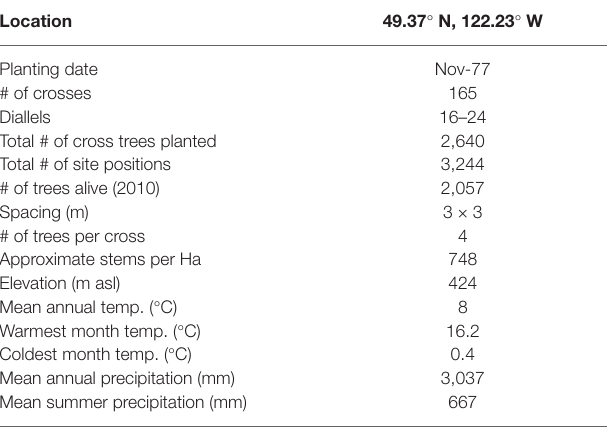
TABLE 1 | Progeny trial summary for the Lost Creek Douglas-fir progeny tests in British Columbia, Canada, including experimental design and climate information. Location